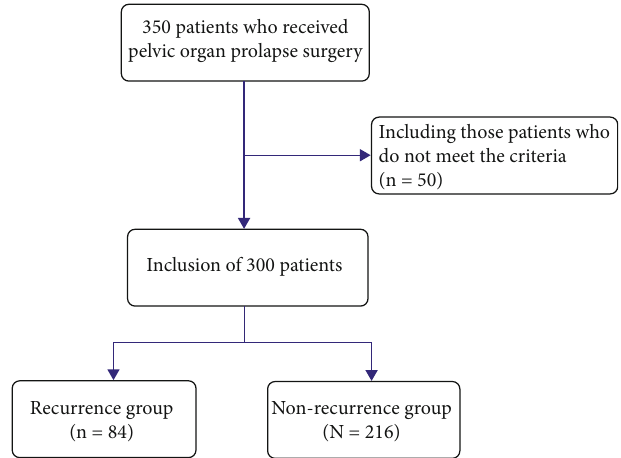
Figure 1: Flowchart of participant recruitment for the current